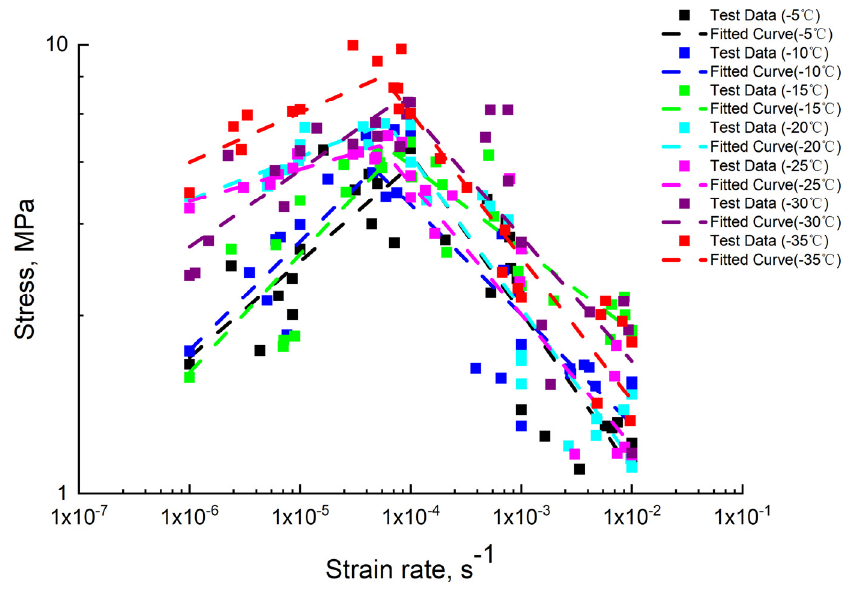
Figure 11. Test data of uniaxial compressive strength versus strain rate and fitted curves for distilled water ice samples grown at different temperatures.